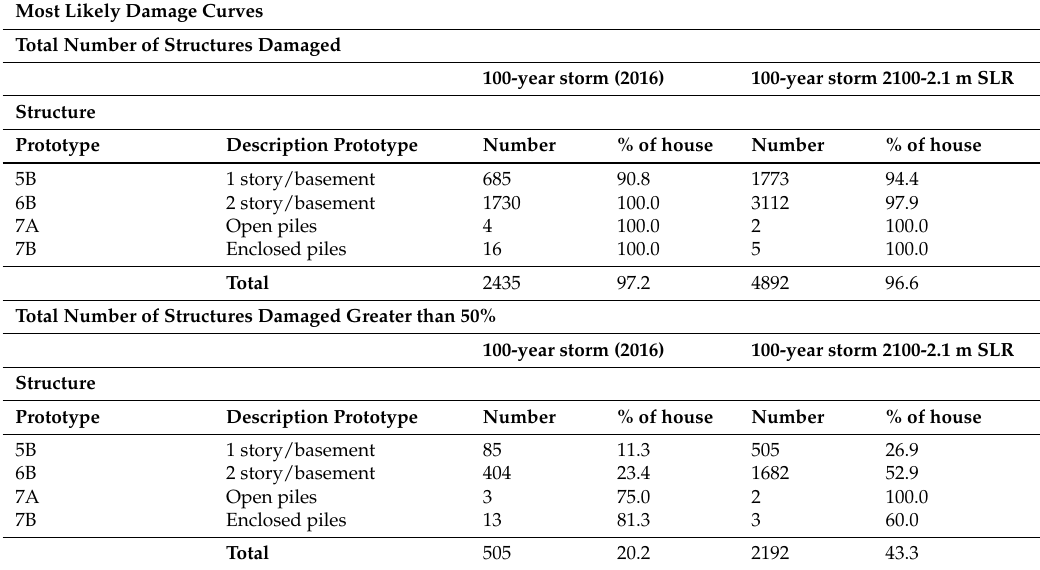
Figure 18. Cumulative structure and content damage curves for Warwick, RI, 100 year. Content damage (C) is shown by the dashed lines and structural damage(S) by the solid lines. Results are shown for the minimum, most likely, and maximum damage function curves. Table 5. Number of structures total and damaged for Warwick, RI study area for various scenarios. Damages are based on the most likely curve. Upper panel shows all structures damaged while lower panel shows structures that are more than 50%